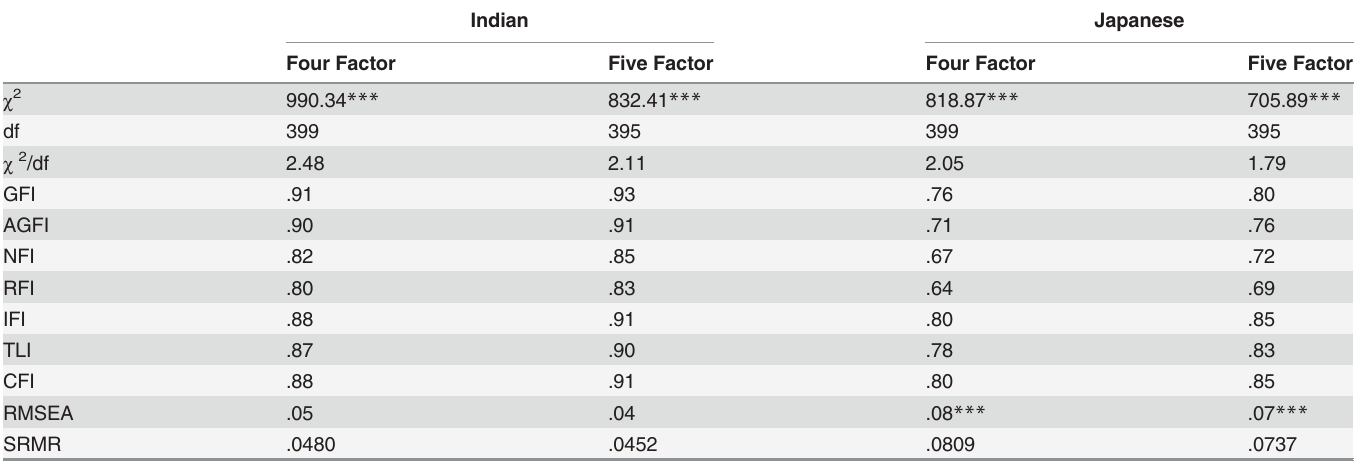
Table 12. Goodness of Fit Statistics for Con fi rmatory Factor Analysis Results for Fully Correlated Four and Five Factor Models for the ESI-R for Indian and Japanese Samples. Indian